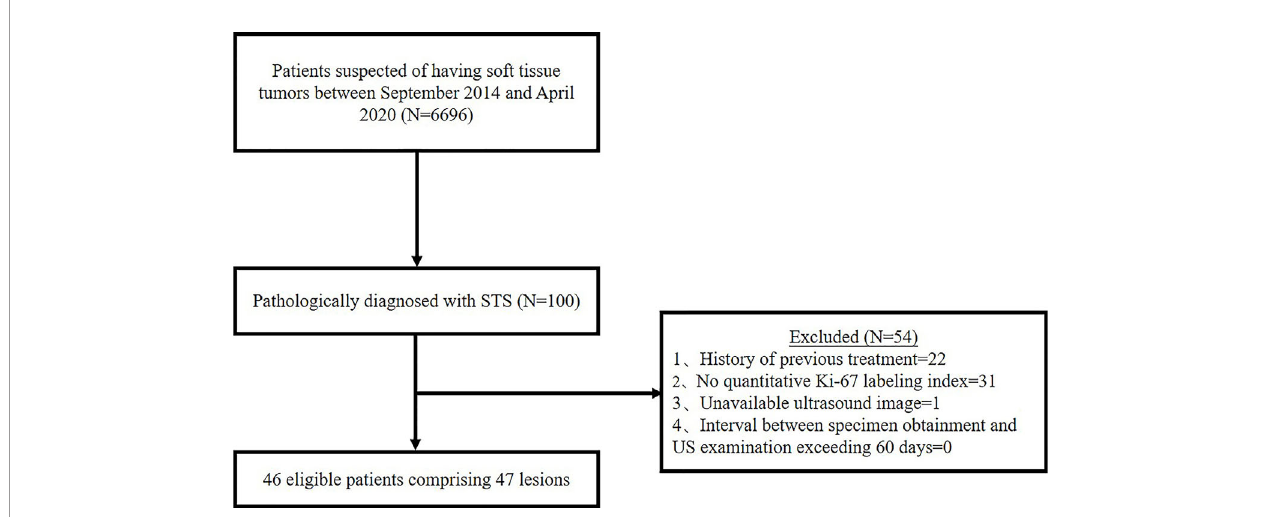
FIGURE 1 | Flowchart of study population selection. (STS, soft tissue sarcoma; N,